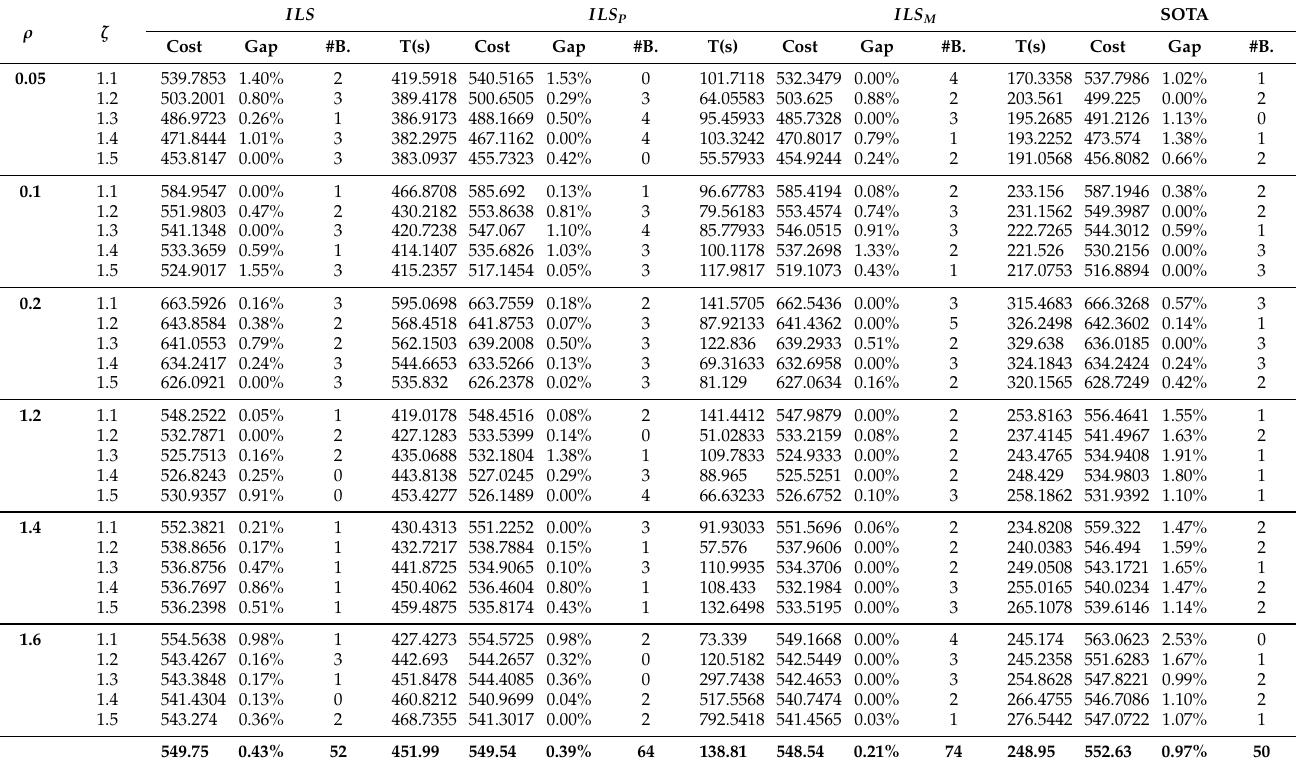
Table 6. Performance comparison for | K | = 50 occasional drivers.